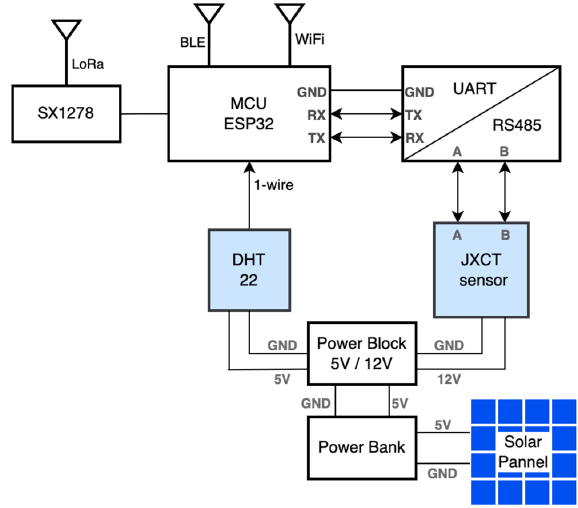
Figure 4. Soil smart sensing node block diagram.